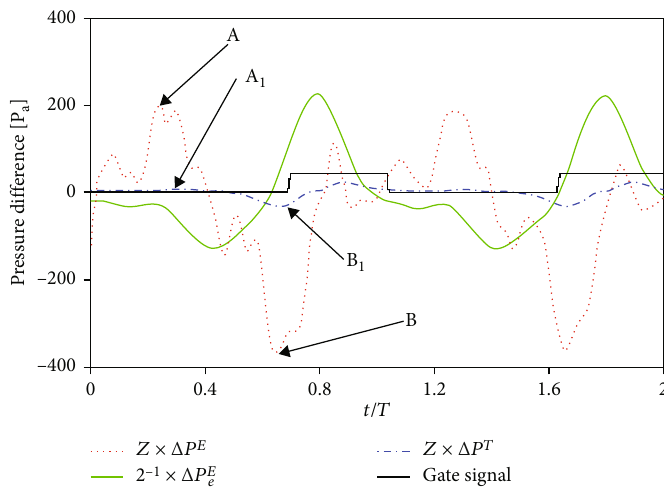
E , as a function e = 7 : 7 Hz , and T = 0 : 129 s . g = 12 : 5 mm . vh